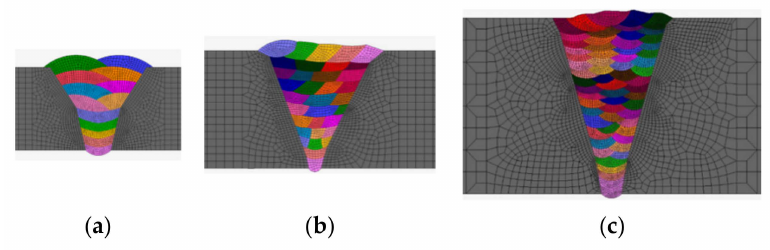
Figure 8. Welding passes for each thickness: ( a ) 25 mm, ( b ) 50 mm, and ( c ) 70